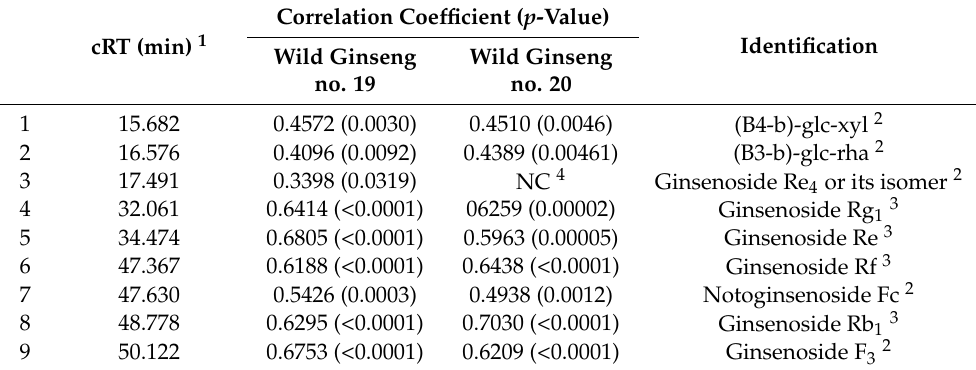
Table 7. Chromatographic peaks recognized by correlation analysis between peak areas and finger- print similarities referring to wild ginseng samples.